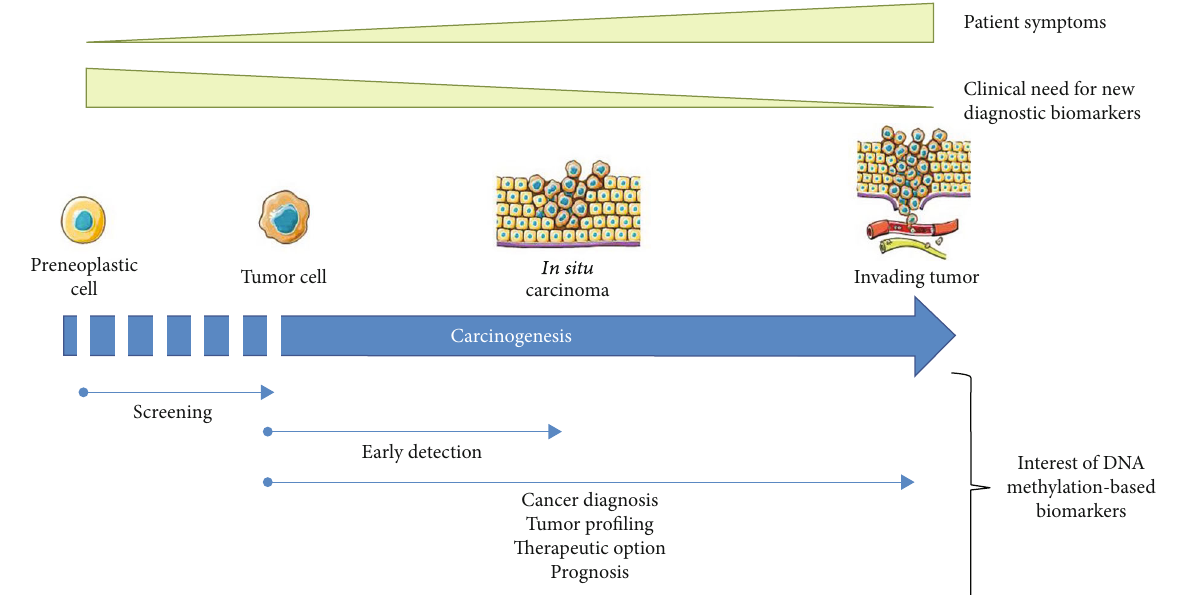
Figure 1: DNA methylation biomarker in cancer diagnosis. Diagram illustrating the preneoplastic cells followed by the screening, early detection, and diagnosis of tumor for the insertion of biomarkers based on DNA methylation. Reproduced with permission from